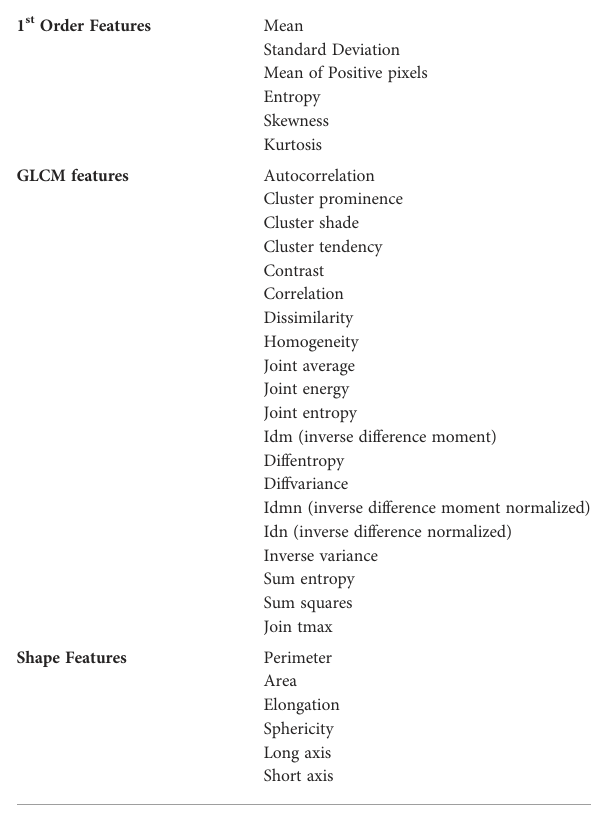
TABLE 3 Radiomic features